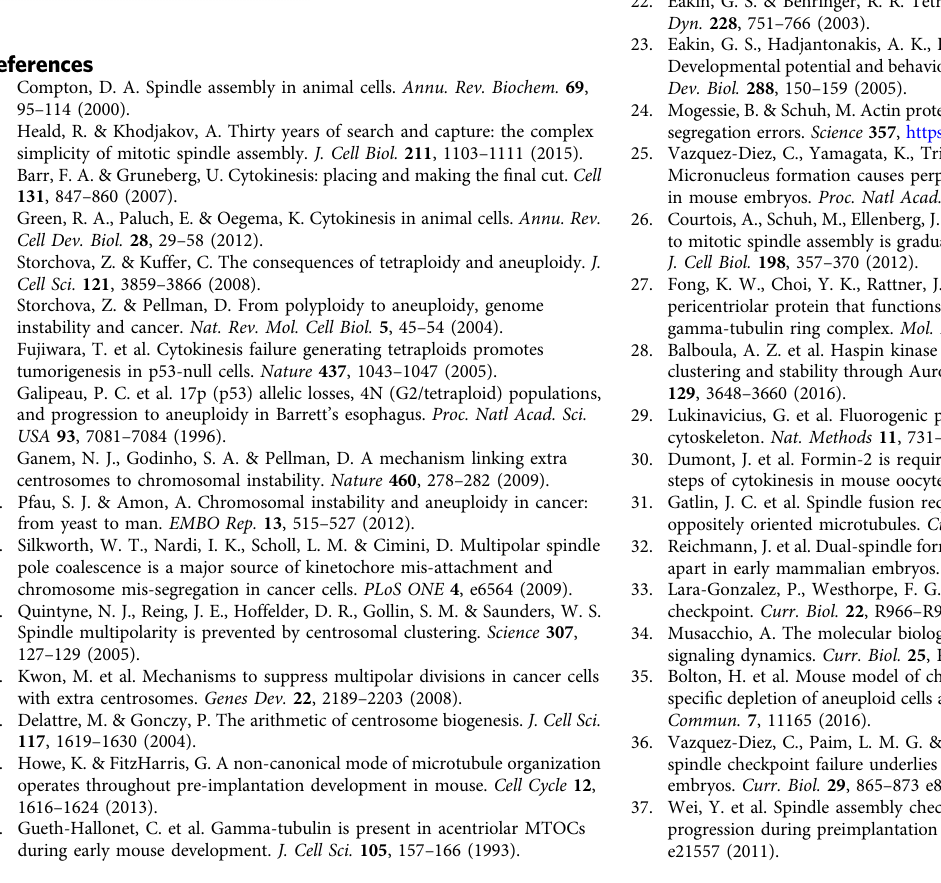
Reporting summary . Further information on research design is available in the Nature Research Reporting Summary linked to this article. Data availability The data related to the fi ndings of this study are available within the manuscript and Supplementary Information, or from the corresponding author upon request. The source data underlying Figs. 1c, e, g, 2c, 3a, b, d, e, 4b, d, f, g, h, 5c, e, g, i, Supplementary Figs. 1b, d, 2a, b, e, 3b, 4a, b, 5c, d, 5e, f, h, 6a – d, 8a, b, d, e, g, h are provided as a Source Data fi le.